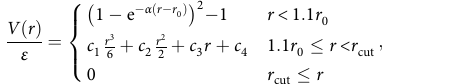
applied in the horizontal direction. The initial vertical box size is constant ( l y = 392 r 0 ) and the box is allowed to expand vertically, e.g. upon debris particle formation.